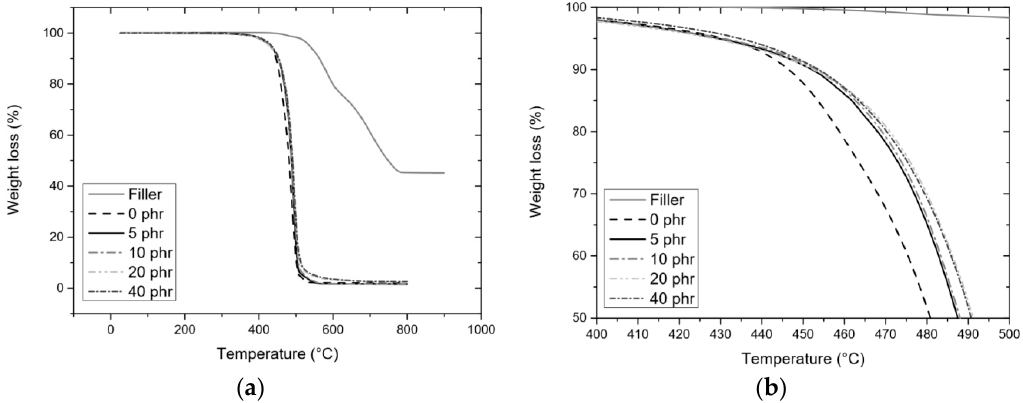
Figure 6. Thermal Gravimetric Analysis (TGA) curves of POSS ‐ P filler and F TP nanocomposites at different filler loading under air. ( a ) unzoomed; ( b ) zoomed. Table 2. Summary of TGA results for POSS fillers and nanocomposites.